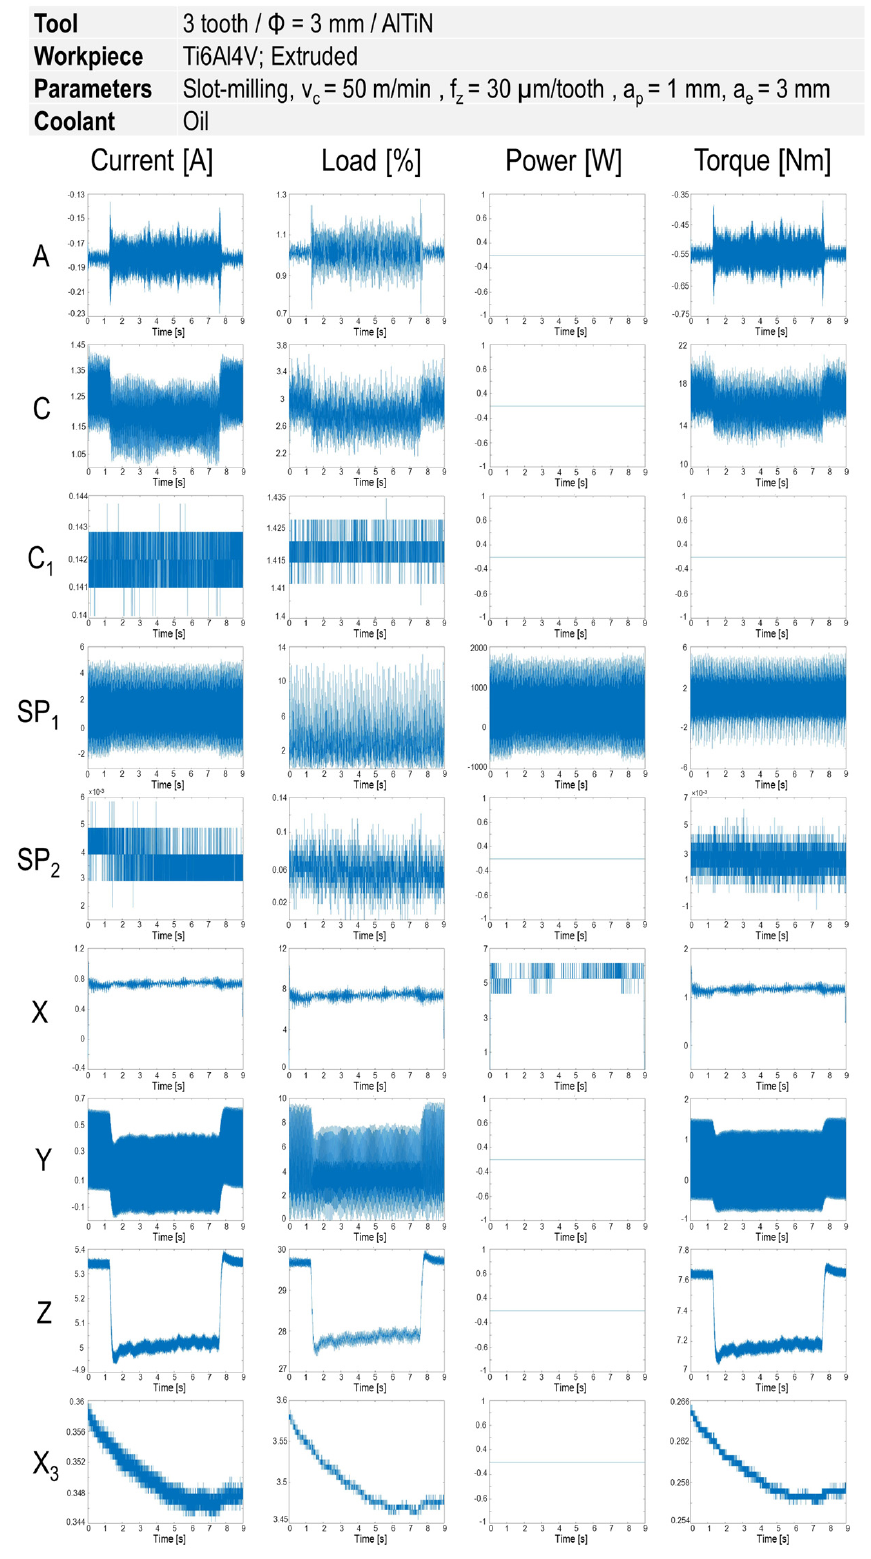
Figure 4. Signals of current, load, power, and torque from different axes and spindle in the slot milling at v c = 50 m/min and f z = 30 µm/tooth.